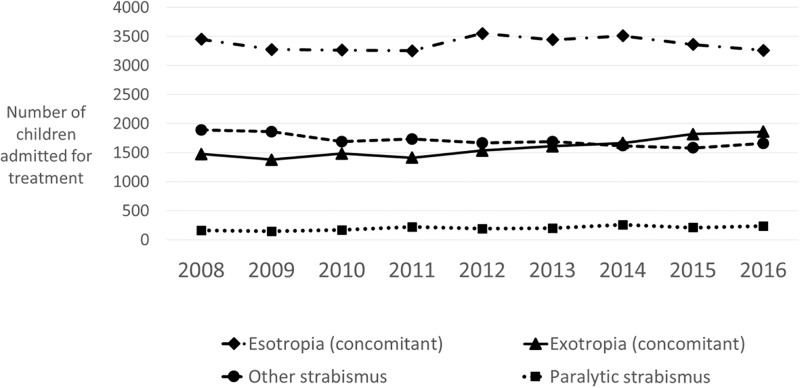
Diagnoses of children admitted to NHS England hospitals for strabismus interventions.Esotropia = convergent strabismus; Exotropia = divergent strabismus; Concomitant = strabismus with equal misalignment in all directions of gaze, ie non-paralytic, non-constrictive, non-restrictive aetiology; Paralytic = associated with extraocular muscle palsy.